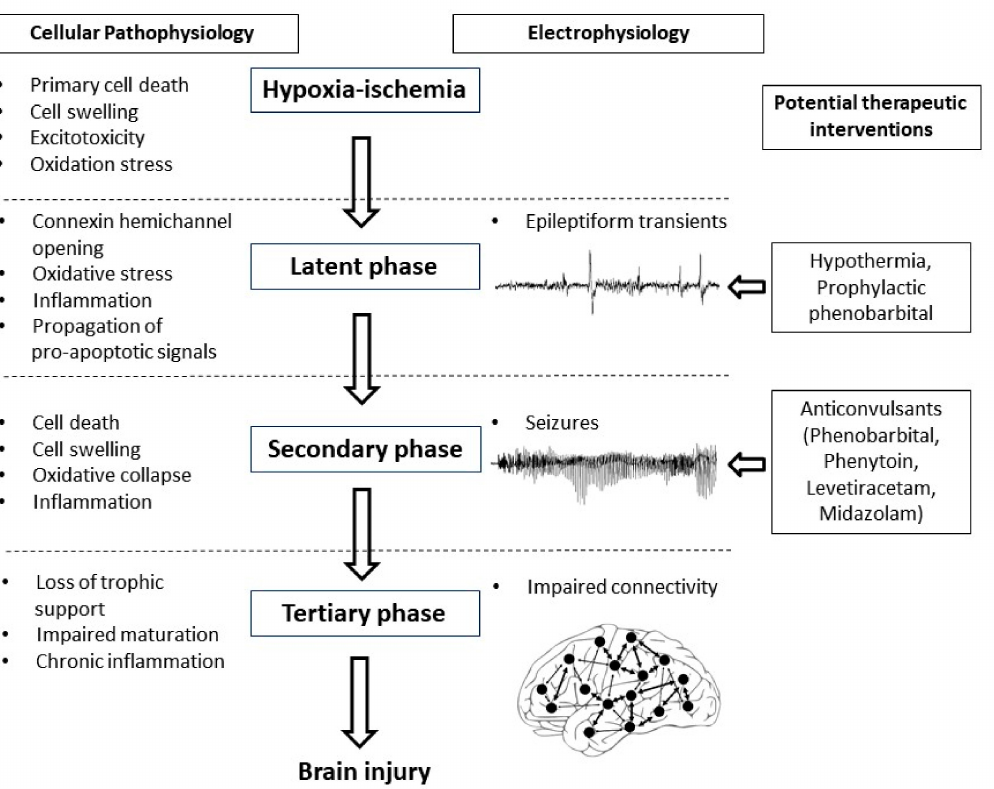
Figure 1. Flow diagram showing the phases of injury including hypoxia-ischemia, the latent phase, the secondary phase and the tertiary phase leading to the development of brain injury. Intervention during the latent phase with therapeutic hypothermia or prophylactic phenobarbital has the potential to reduce the development of brain injury as well as the occurrence of seizures. Intervention during the secondary phase with anticonvulsants such as phenobarbital, phenytoin, levetiracetam and midazolam may reduce seizure activity but their effects on long-term outcome are not